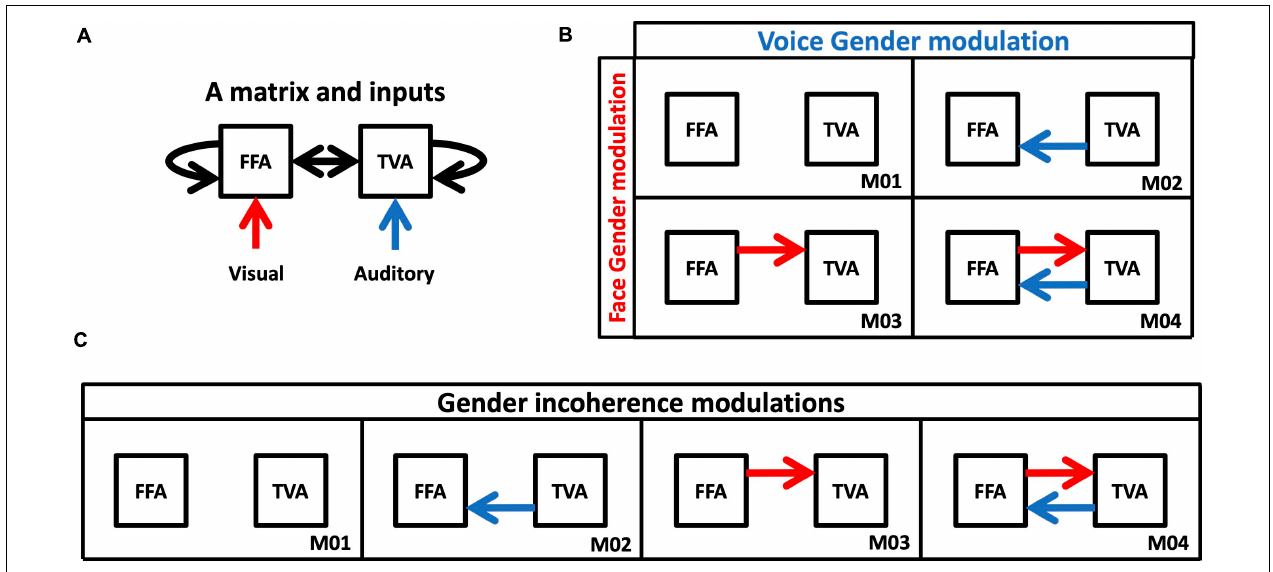
FIGURE 4 | Models of DCM analysis. (A) Inputs and intrinsic connectivity that were applied to all cases. (B) Model space for changes in effective connectivity to test gender effects. Red arrows represent changes in connectivity from FFA to TVA in response to face gender (compared to gender-neutral). Blue arrows represent changes in connectivity from TVA to FFA in response to voice gender (compared to gender-neutral). (C) Model space for changes in effective connectivity to test congruence effects. Red and blue arrows both represent changes in effective connectivity when face and voice gender are incongruent (compared to